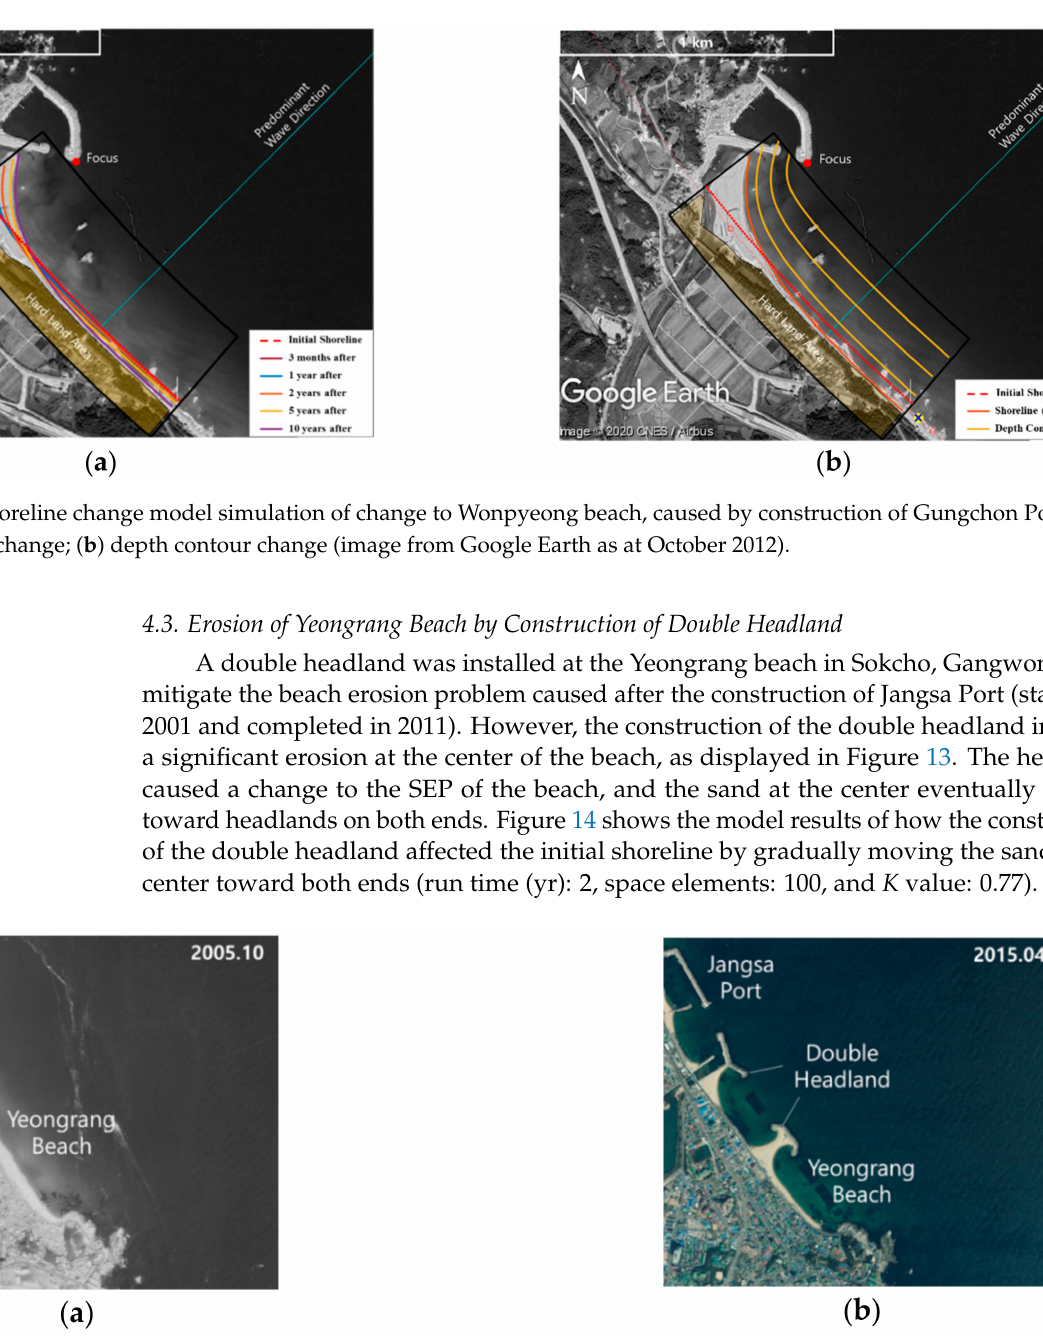
Figure 13. Yeongrang beach before and after construction of double headland: ( a ) October 2005 (image from NGII); ( b ) April 2015 (image from